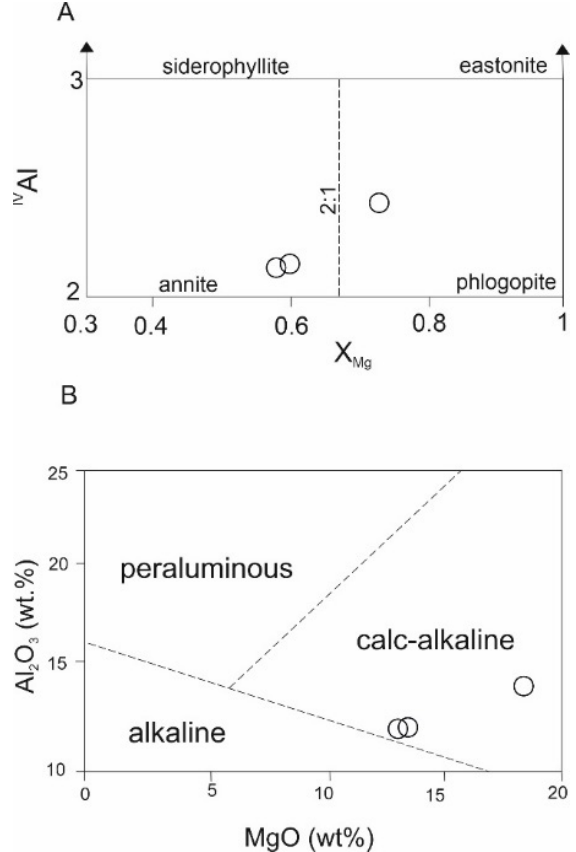
Figure 5. ( A ) Classification diagram of studied micas. End-members names according to Rieder et al. [51]; ( B ) Position of studied mica in the classification diagram of Abdel-Rahman [52] for micas from different magmatic series. 1—sample M-1.